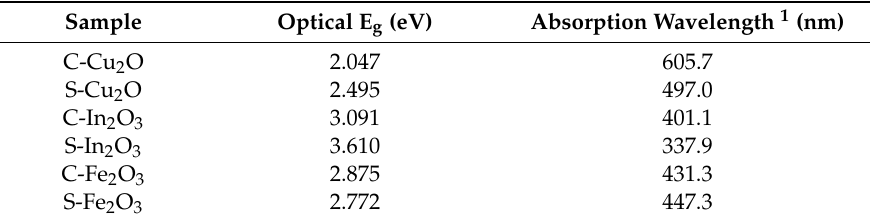
Table 4. Optical energy gap and corresponding absorption wavelength in binary oxide